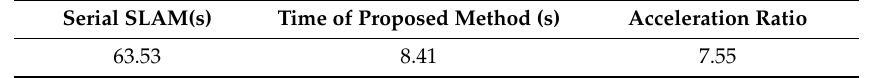
Table 3. Evaluation results in terms of reconstruction time (parallel and serial SLAM algorithm). Serial SLAM(s)